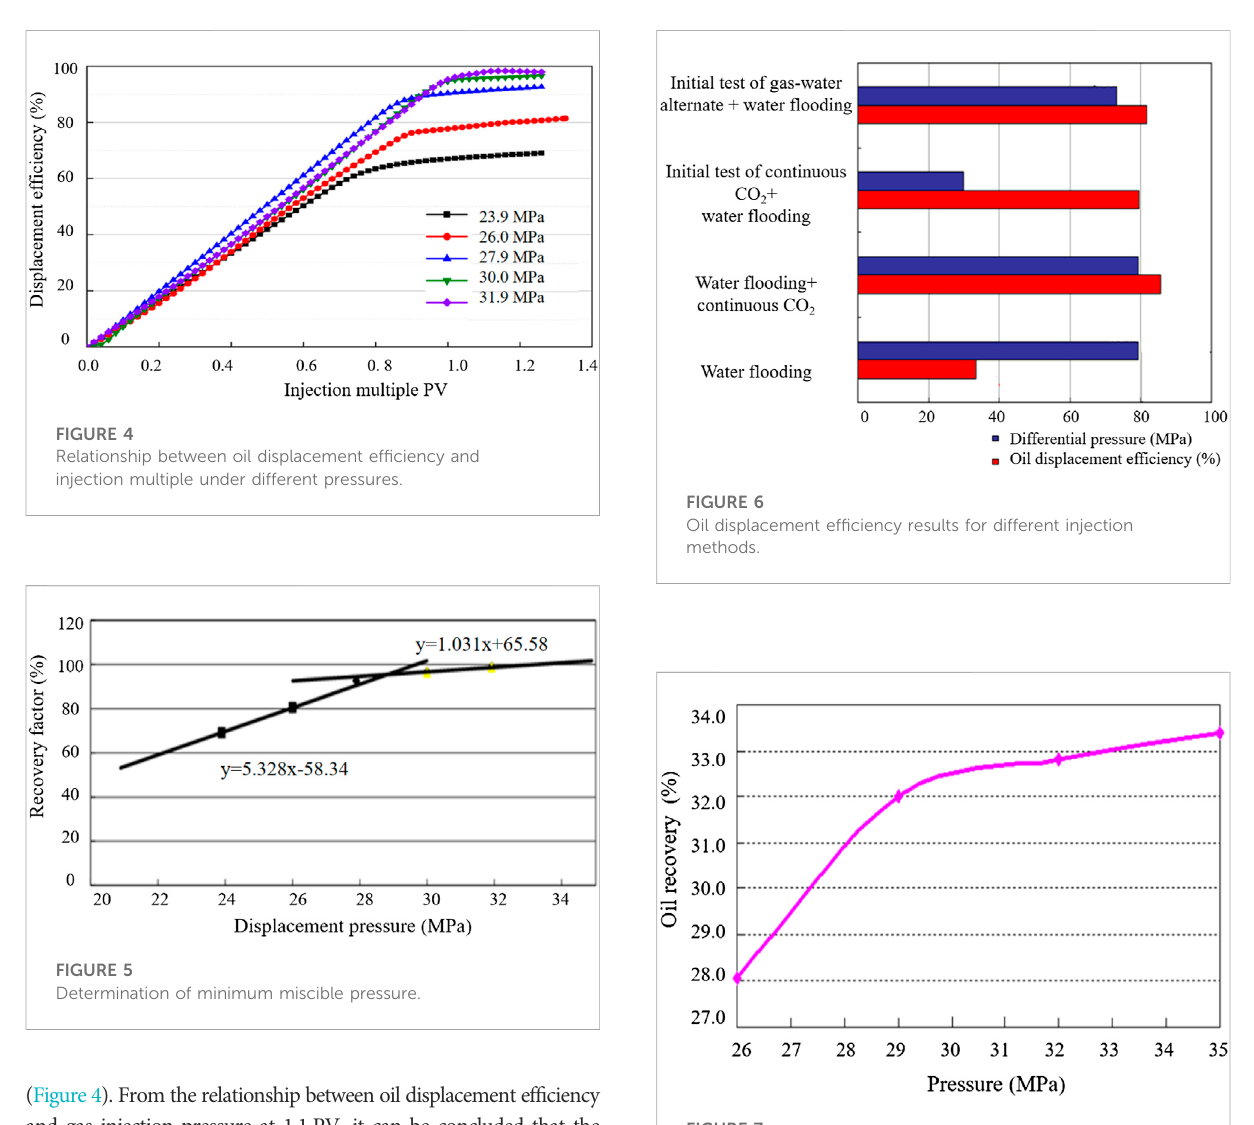
(Figure 4). From the relationship between oil displacement ef fi ciency and gas injection pressure at 1.1 PV, it can be concluded that the minimum miscible pressure in block XX is 28.94 MPa, and the corresponding oil displacement ef fi ciency is 95.4% (Figure 5).